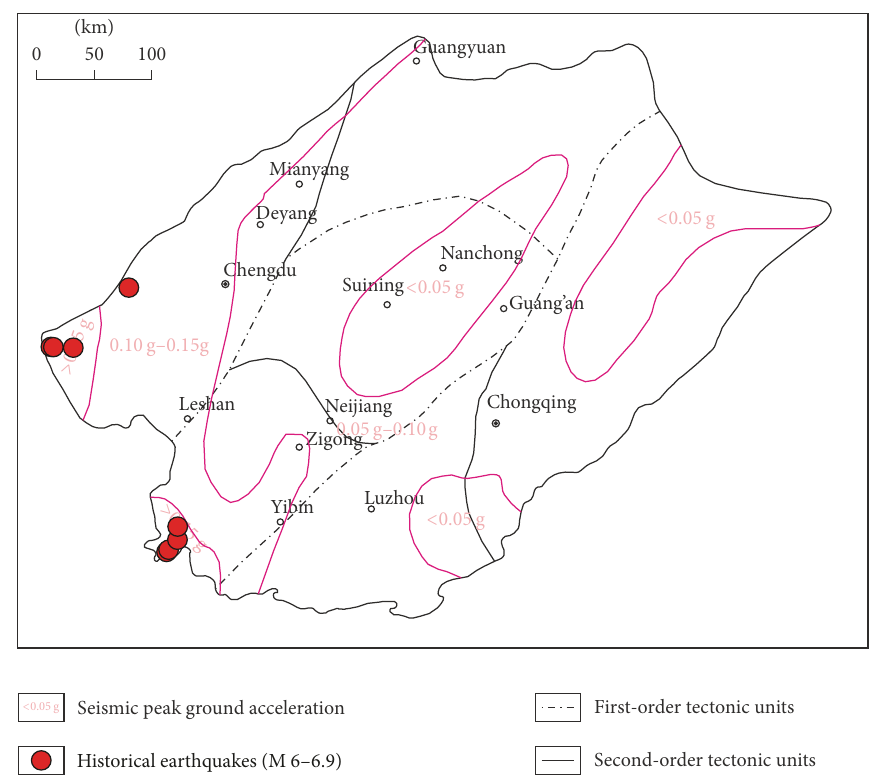
Figure 4: Seismic peak ground acceleration and large historical earthquakes in the Sichuan Basin. The peak ground acceleration is less than 0.10 g in most parts of the Sichuan Basin. Only in the western margin of the Sichuan Basin, the peak ground acceleration is larger than 0.15 g.